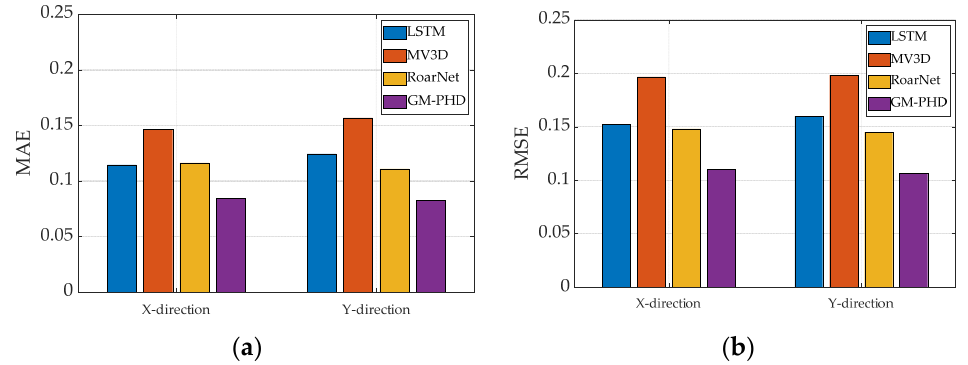
Figure 10. Comparison of MAE and RMSE between the LSTM, MV3D, RoarNet, and GM-PHD models. ( a ) The comparison results under MAE metric; ( b ) The comparison results under RMSE metric.